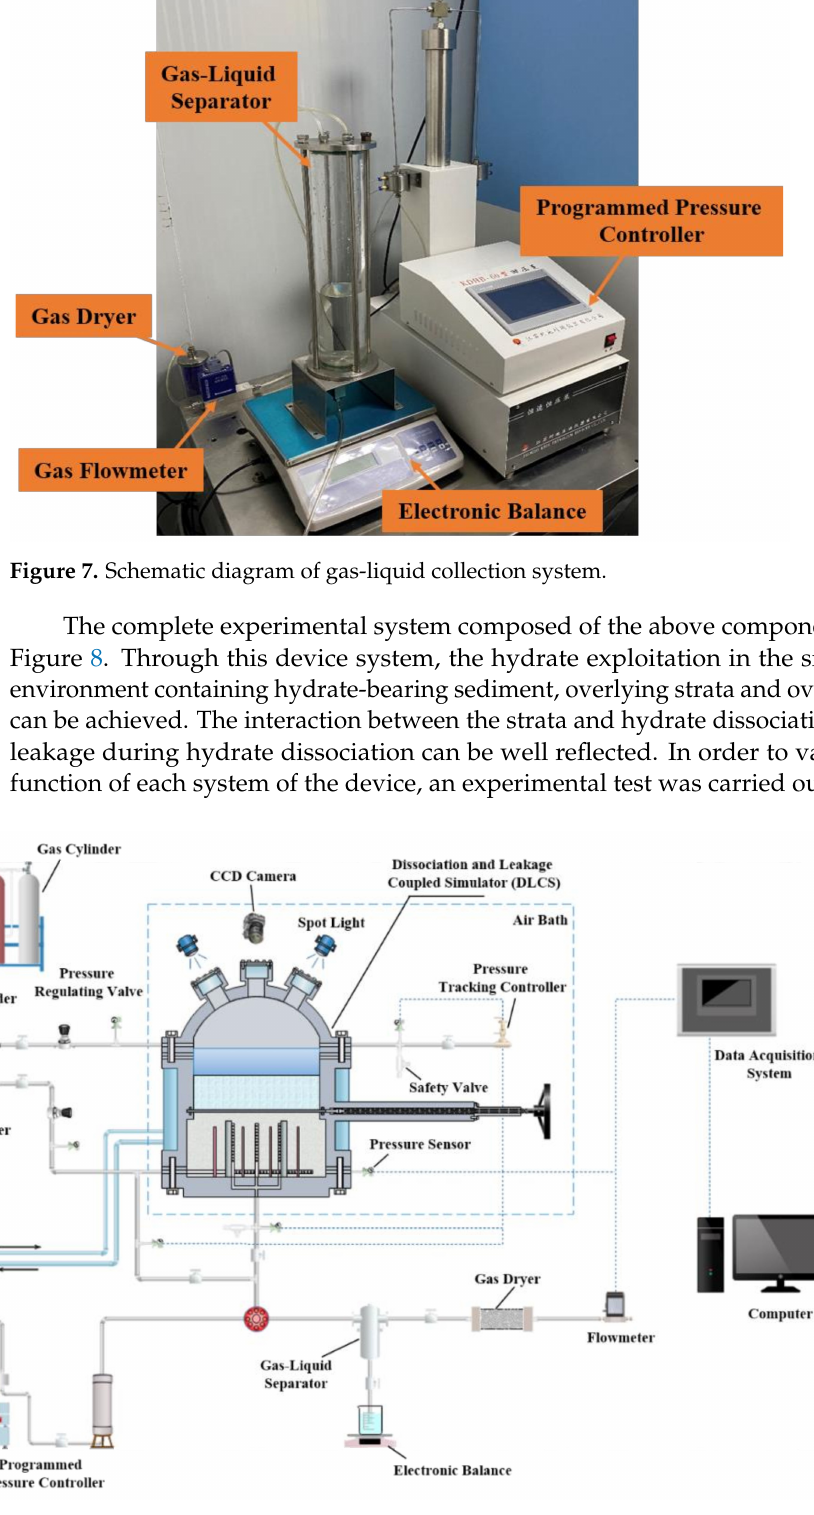
Figure 8. Schematic diagram of the complete experimental